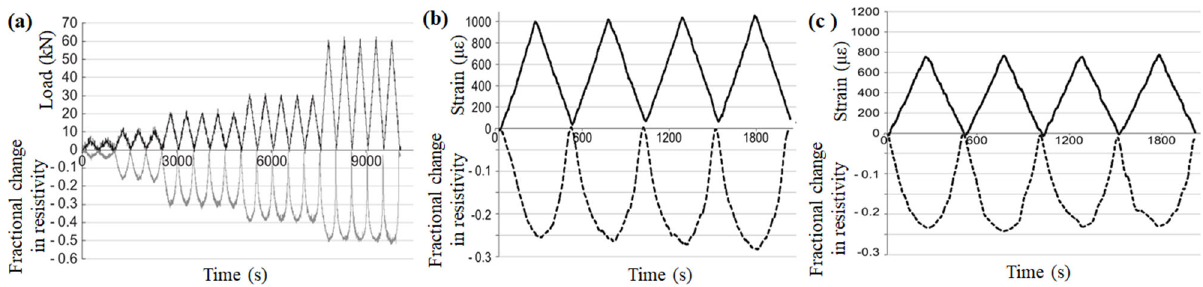
Figure 11. Response of CFRC under cyclic compressive loading at ( a ) different load amplitudes, ( b ) 15 wt.% CFs, and ( c ) 15 wt.% CFs + 1 wt.% CNT [111].